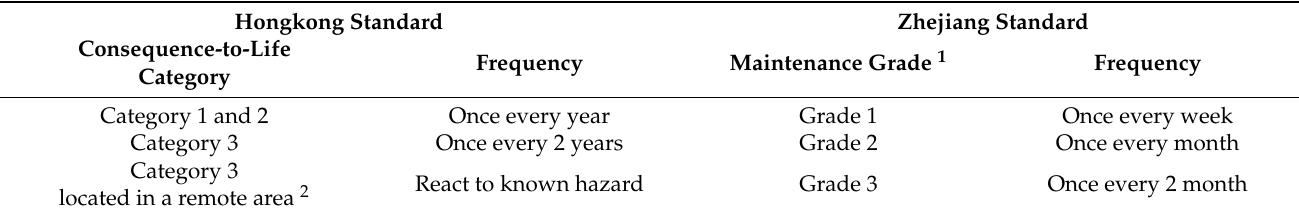
Table 1. Frequency of routine maintenance